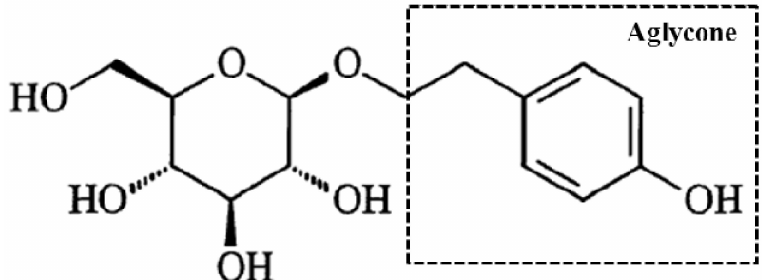
Figure 1. Chemical structural formula of salidroside (p-hydroxyphenethyl- β -D-pyran glucoside, Mr = 300.3). Aglycone denoted with the dotted box is the radical-scavenging active structure of salidroside in